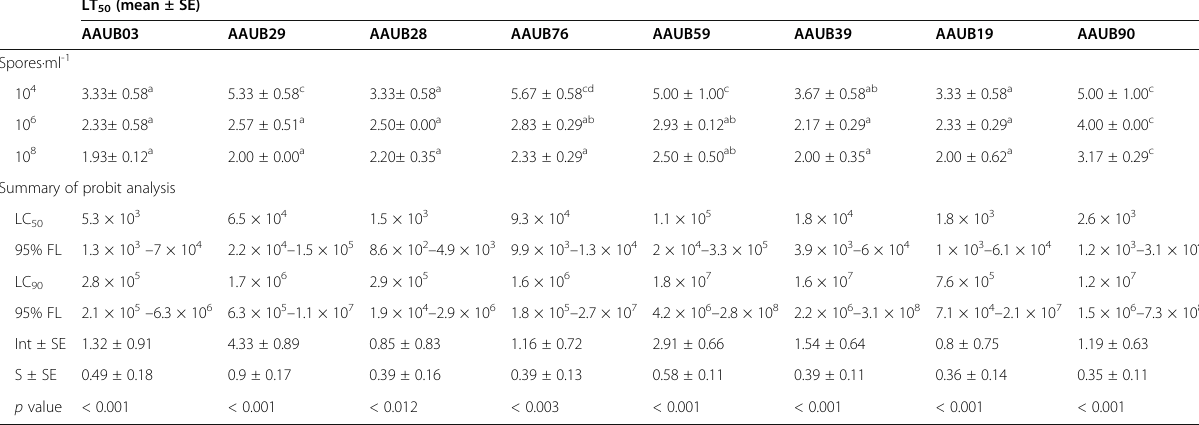
Table 3 The LT 50 determination and summary of probit analysis to determine LC 50 and LC 90 concentrations of Beauveria bassiana strains against the third instar of Tuta absoluta larvae in 10 days post